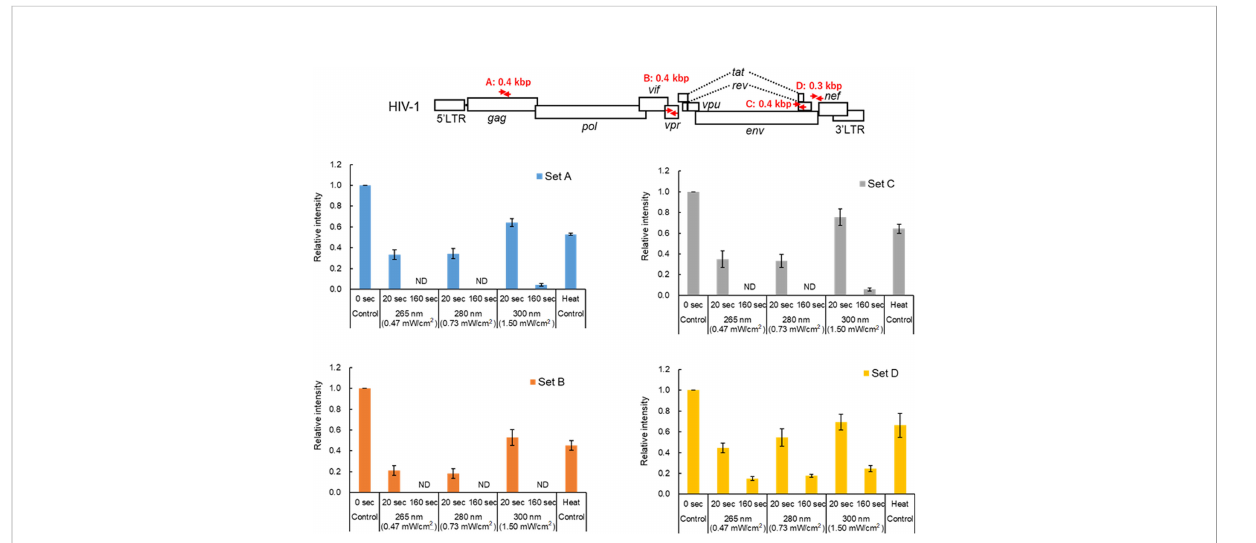
failure of the subsequent PCR ampli fi cation. All virus samples exposed to UV at 300 nm showed relatively higher signal intensities compared to those irradiated UV at 265 and 280 nm, implicating weaker damage by UV irradiation at 300 nm